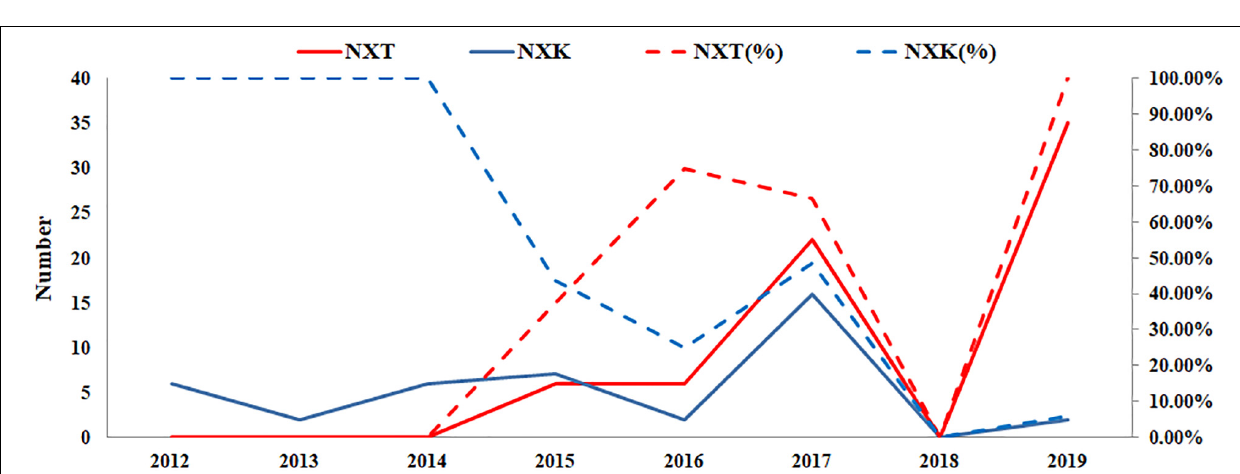
FIGURE 5 | Worldwide prevalence of the glycosylation motif site at position 158 from 1968 to 2019. The sequences of 62,330 clinical strains worldwide from 1968 to 2019 were collected from GISAID. The substitutes at position 158–160 were analyzed.